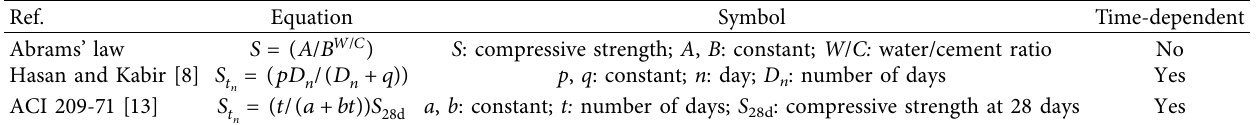
Table 1: Summary of the empirical equations for determining the compressive strength of concrete.